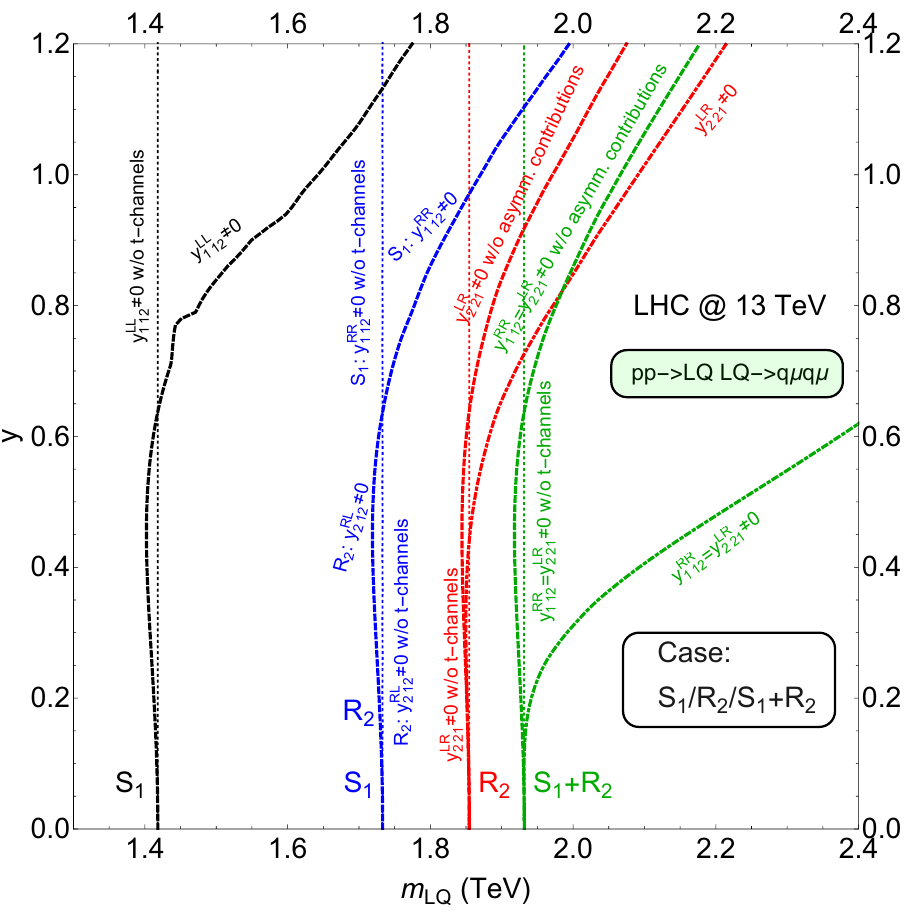
Figure 6 . The leptoquark parameter space limits for the S 1 , R 2 , and S 1 + R 2 scenarios extracted from the pp → LQLQ → jjµµ process search [1] performed at 13 TeV center-of-mass energy of proton-proton collisions at the LHC, using an integrated luminosity of 139 fb − 1 . See text for more